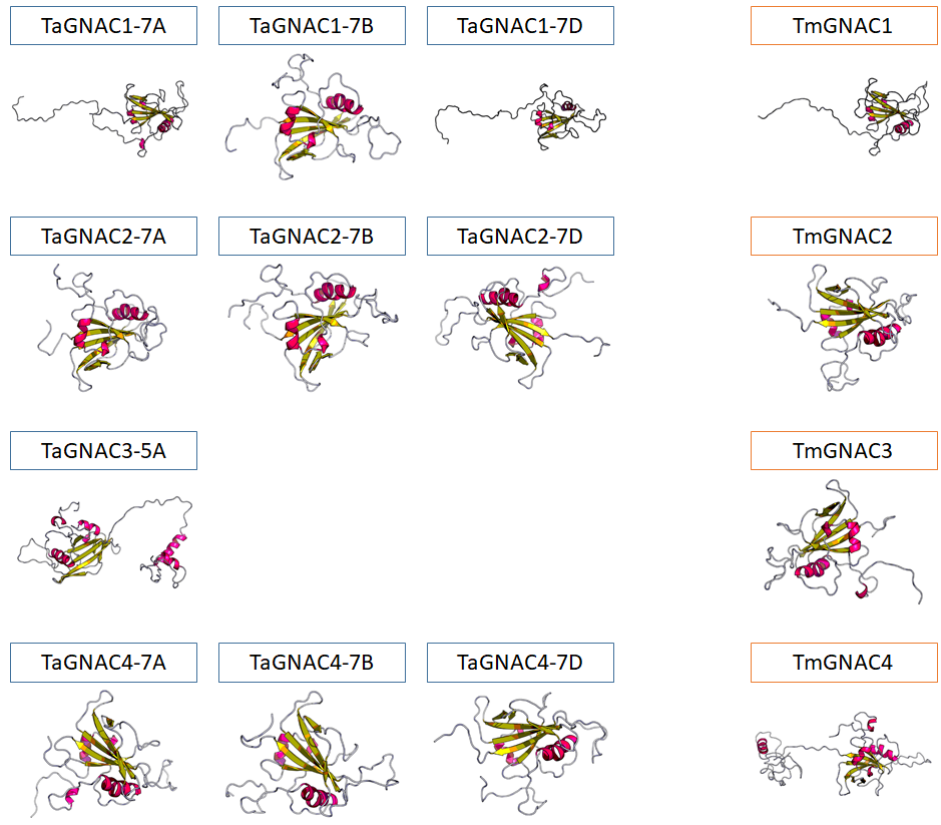
Figure 2. Tertiary structure of the TaGNAC and TmGNAC proteins. Pink: alpha-helix; yellow: beta- sheets.